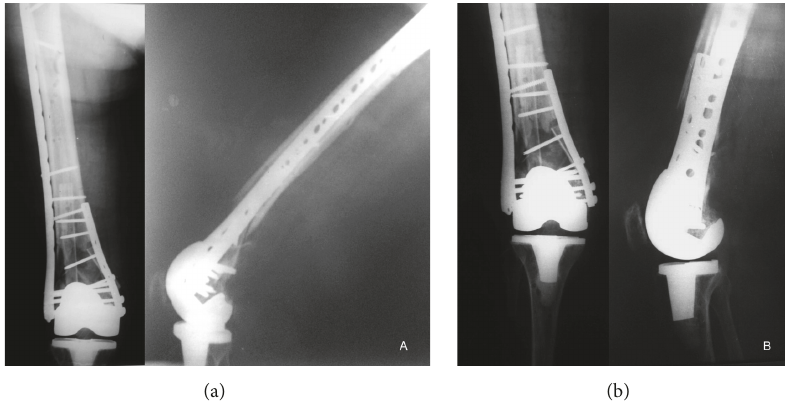
Figure 2: Immediate postoperative X-rays showing good reduction of the fracture, anatomic alignment of the articular surface, and rigid fixation. (a) Note the nonvascularized fibular strut graft. The larger piece was used to bridge the metaphyseal defect and the small piece to replace the medial wall of the distal femur. (b) The alignment of the knee joint was anatomically restored.